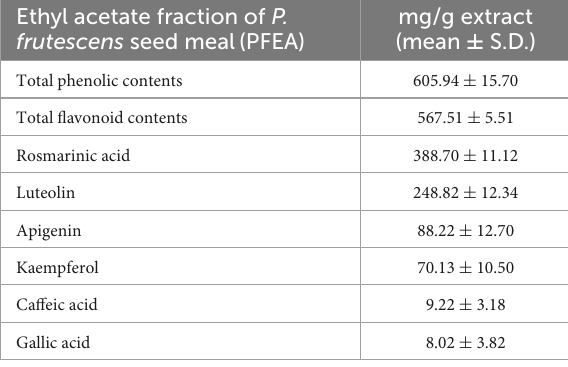
Dataarepresentedasmean ±